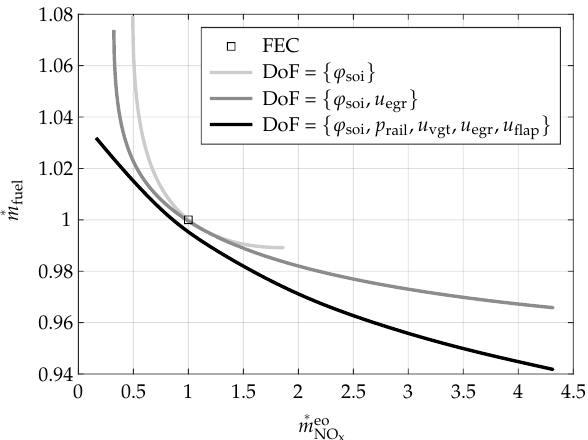
Figure 2. Pareto fronts showing the trade-off between fuel consumption and engine-out NO x emissions for different sets of DoF at fixed engine speed and torque. All values were